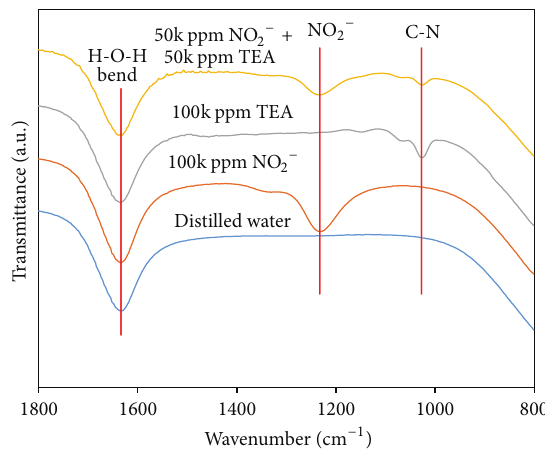
Figure 9: FT-IR spectra representing the effect of increasing concentrations of inhibitor in distilled